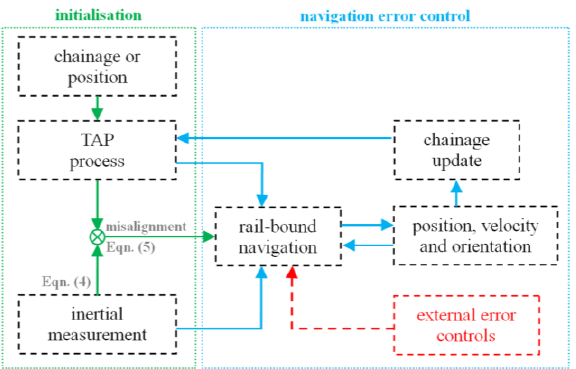
Figure 2. configuration of rail-bound navigation.